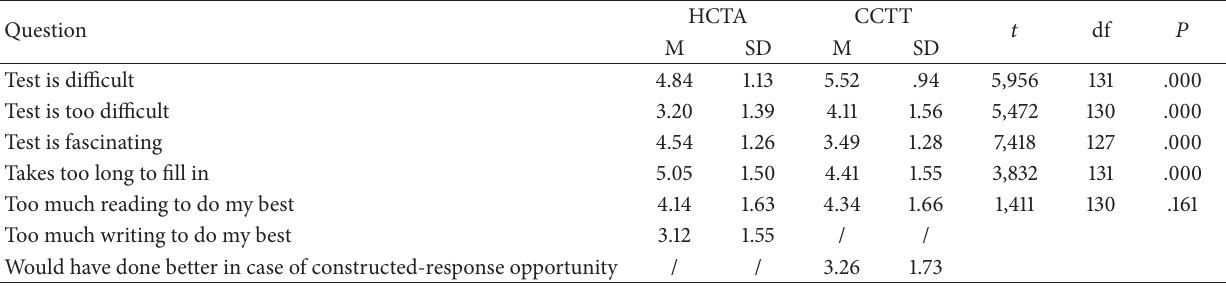
Table 11: Students’ opinions on the HCTA and the CCTT ( 𝑁 = 132 ).